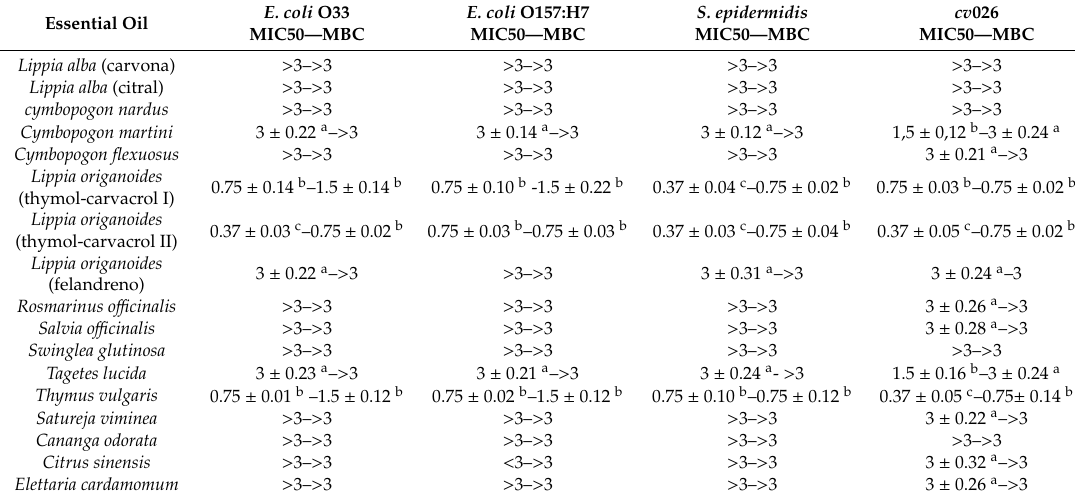
Table 2. Minimal inhibitory concentration to inhibit 50% of bacterial population (MIC 50 ) and minimal bactericidal concentration (MBC) (mg / mL) determined for the essential oils assessed. Values are means ± SD of triplicate determinations. ANOVA ( p < 0.05) was performed, followed by Tukey’s Test. Di ff erent letters indicate significant di ff erences between the tested